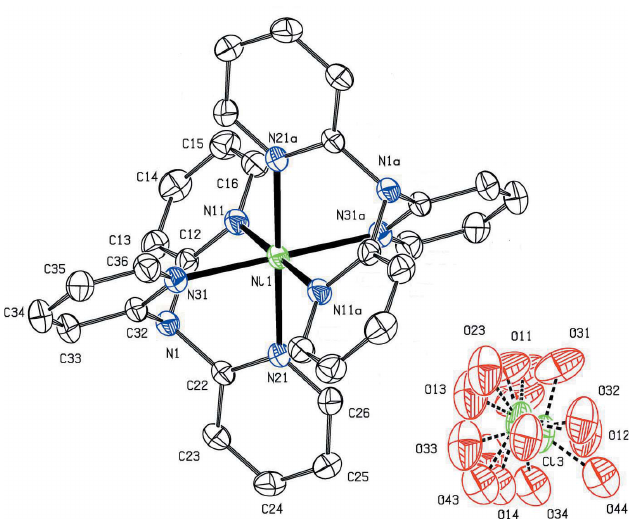
Figure 2 The ionic components of compound (III), with atom labelling and displacement ellipsoids drawn at the 30% probability level. For clarity, the H atoms and the symmetry-equivalent anion have been omitted, and unmarked atoms and atoms marked ‘a’ are at the symmetry position ( (cid:5) x + 1, (cid:5) y + 1, (cid:5) z + 1).